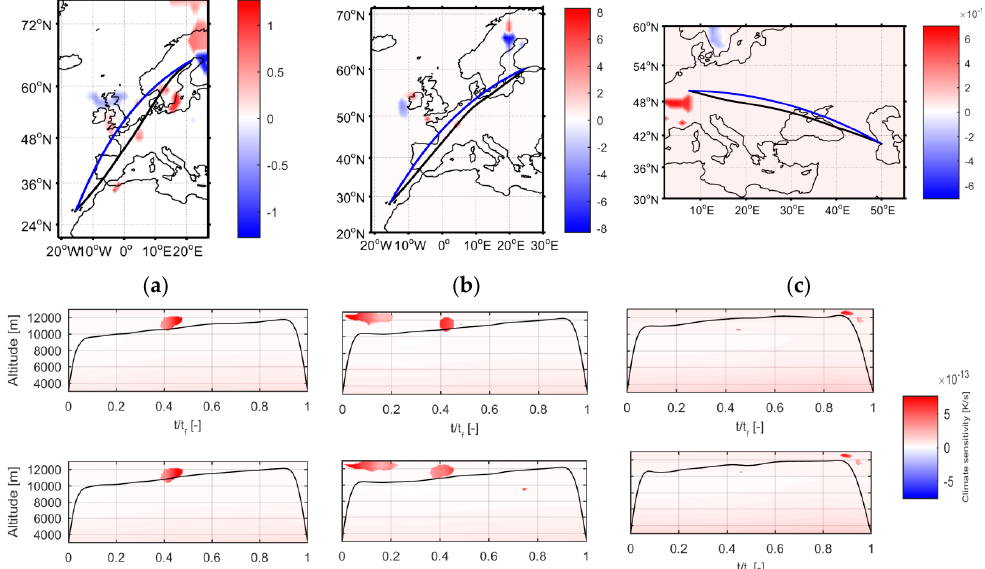
Figure 1. Aircraft trajectories (top row) Lulea–Gran Canaria (ESPA-GCLP, a ), Helsinki–Gran Canaria (EFHK-GCLP, b ), Baku–Luxembourg (UBBB-ELLX, c ): great circle (blue line), fuel-optimized trajectory (black line). Altitude profile: fuel optimal case (middle row) and climate optimized case with 0.5% additional costs (bottom row), indicating along individual cruise trajectories of the connection (altitude, position) by shading algorithmic climate change functions warming (red) and cooling impacts (blue), values provided as 10 − 13 K/s.